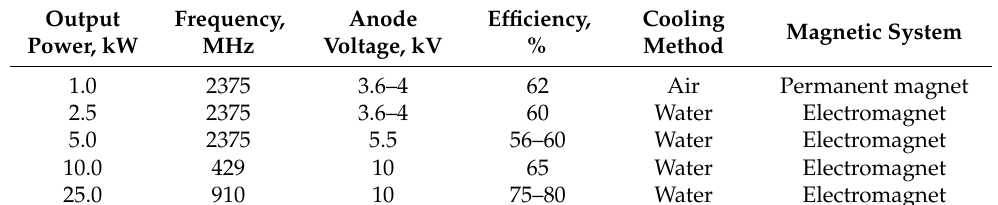
Table 2. Characteristics of magnetrons [54].